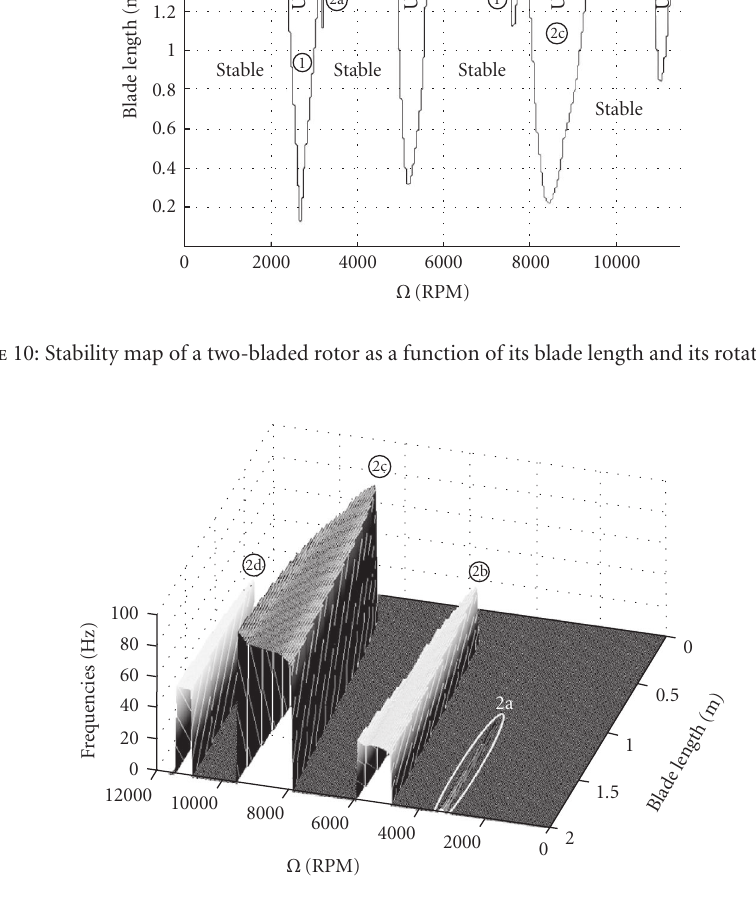
Figure 11: Unstable frequencies of a two-bladed rotor as a function of its blade length and its rotational